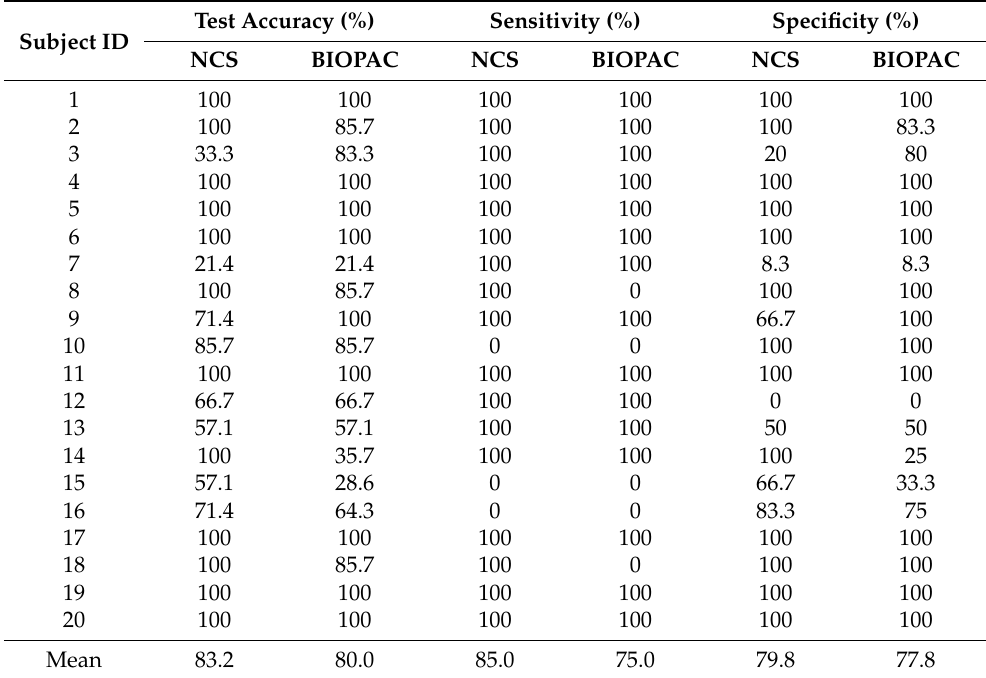
Table 3. Personalized prediction model performance across subjects.